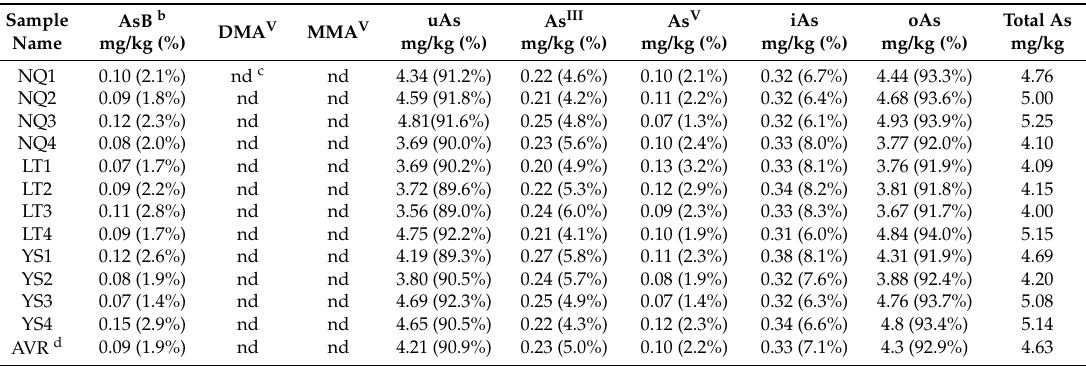
Figure 5. Inference on the toxicity of the unknown As detected in O. sinensis. (a) 1 mL of H 2 O 2 was added to the extracts, and the unknown As could not be oxidized (Figure 4C). Thus, the unknown As cannot be the toxic MMA III , DMA III , or DMMTA V which can be oxidized under treatment with H 2 O 2 . (b) The unknown peak presents a similar retention time with As III , indicating that it is not a low retention component, such as an As hydrocarbon (AsHC). Table 4. Concentration a of total arsenic and arsenic species in Ophiocordyceps sinensis.